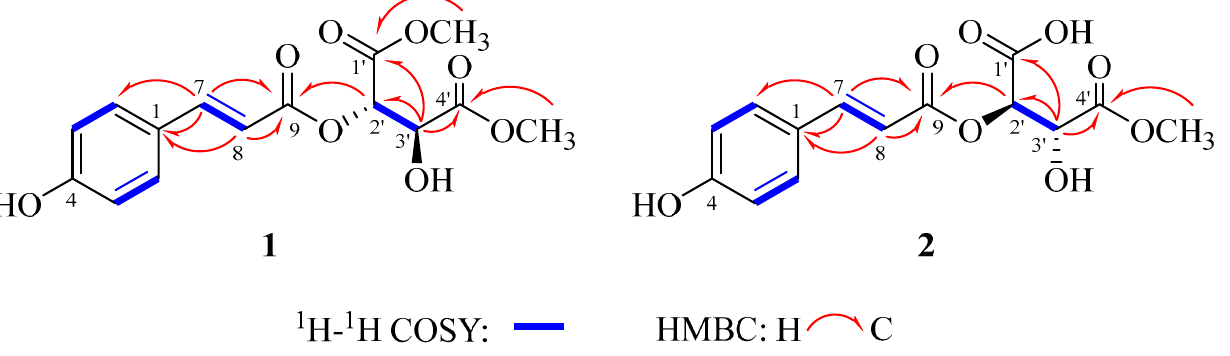
Figure 2. Key 1 H- 1 H COSY and HMBC correlations for compounds 1 and 2